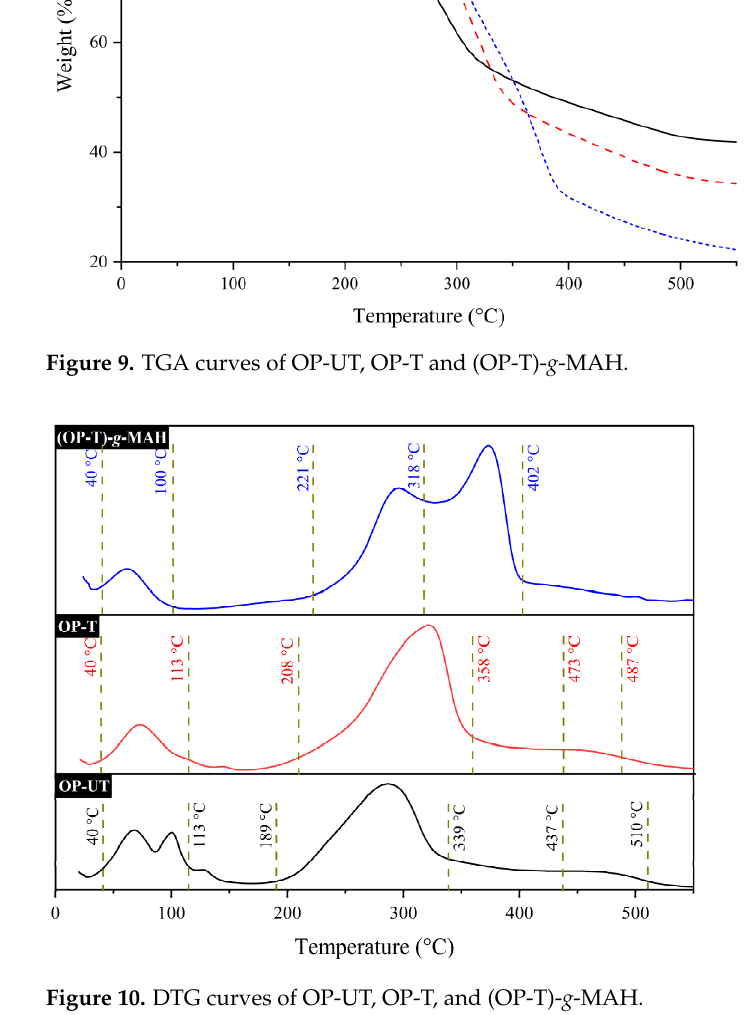
Figure 10. DTG curves of OP-UT, OP-T, and (OP-T)- g -MAH.